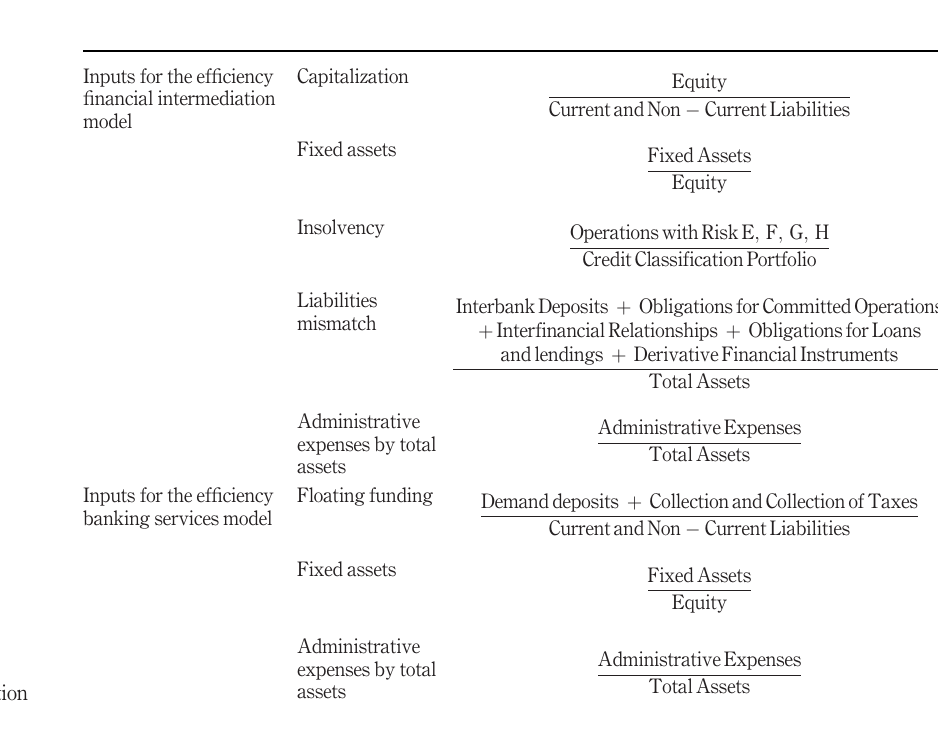
Table 6. Input calculation formulas